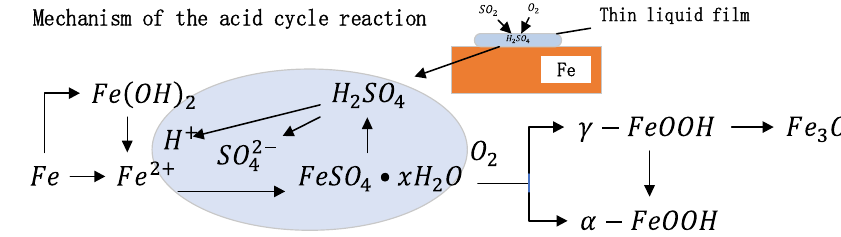
Figure 2. Industrial atmospheric corrosion mechanism of steel.